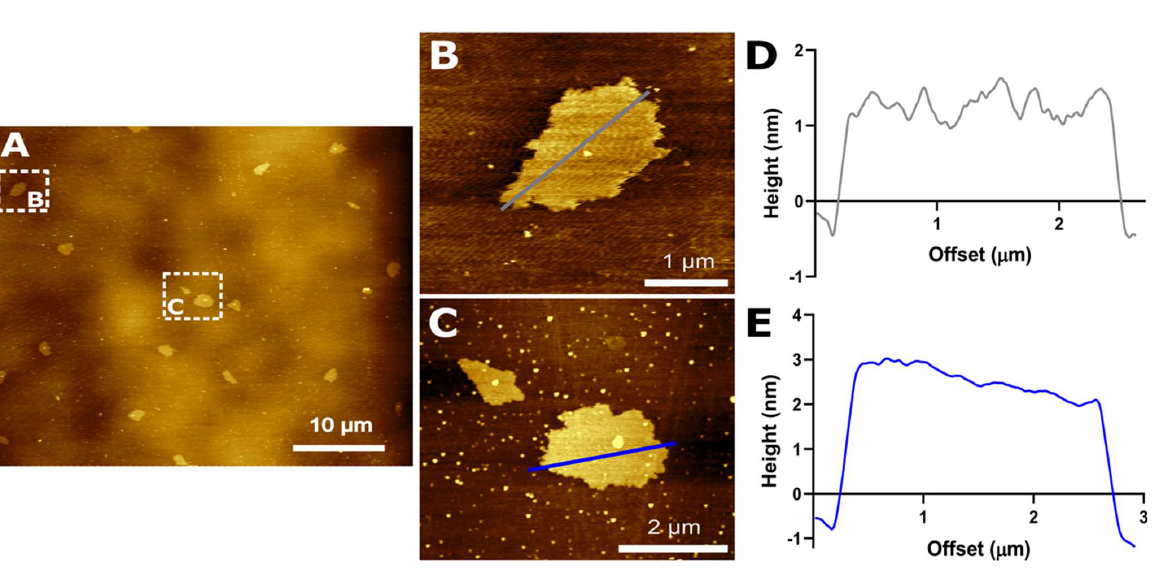
Figure 2. ( A ) AFM image of GO. ( B , C ) correspond to more detailed observations of GO nanosheets in Figure 2A. The height profiles of ( B , C ) GO nanosheets are shown in ( D , E ),